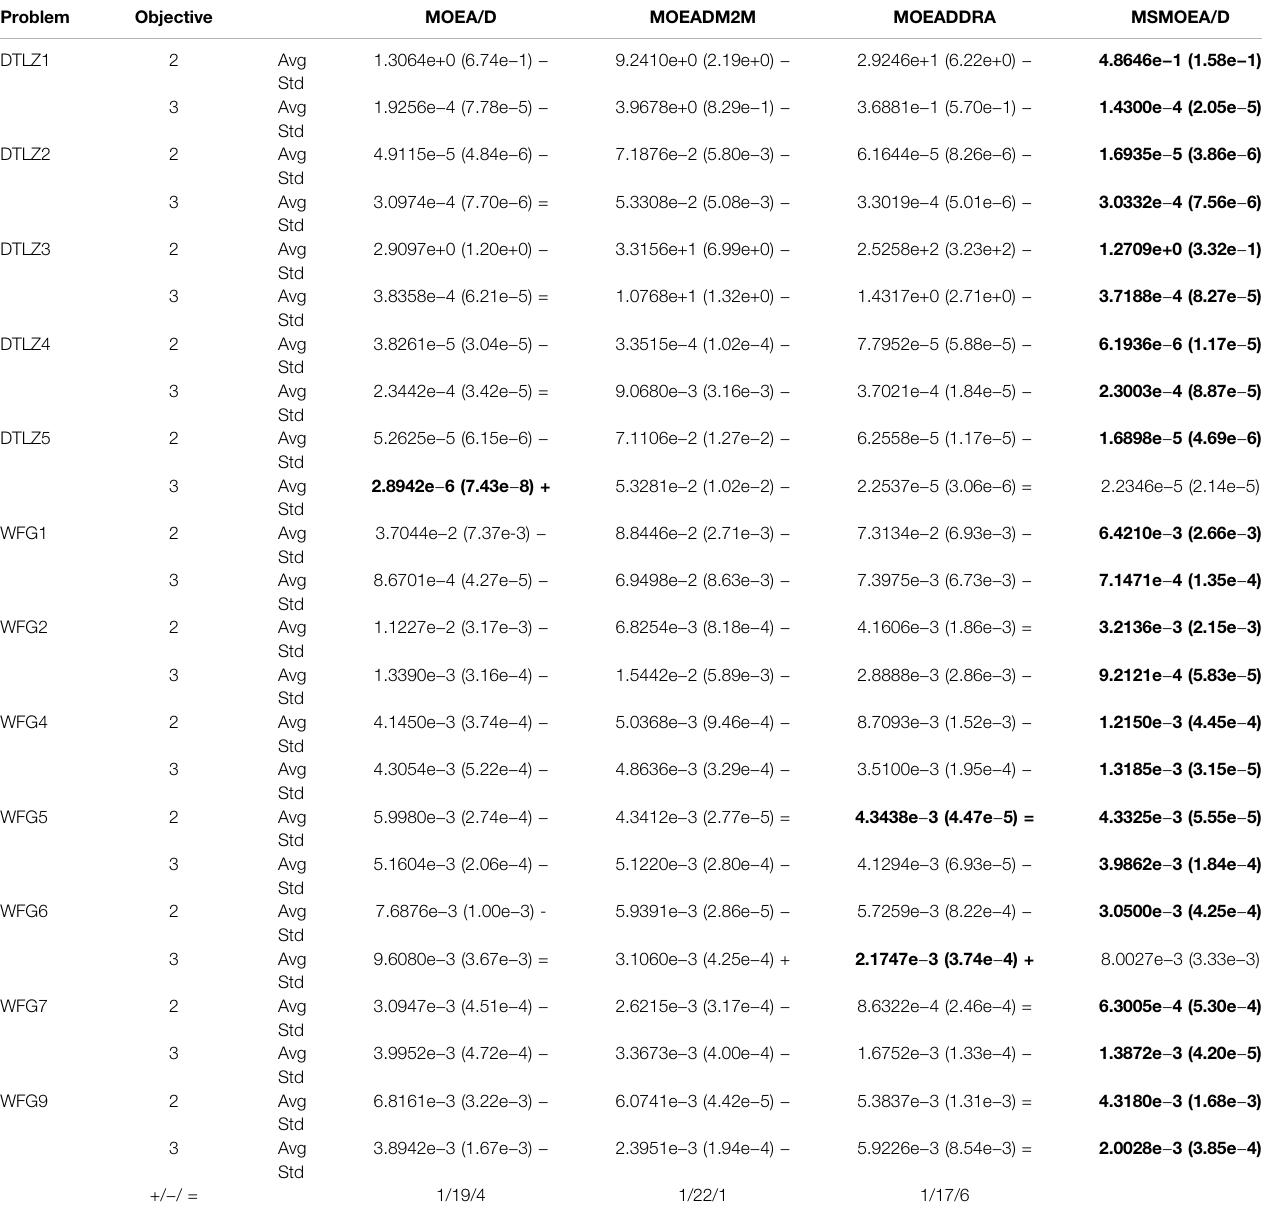
TABLE 2 | Comparison of GD values of all algorithms. Problem